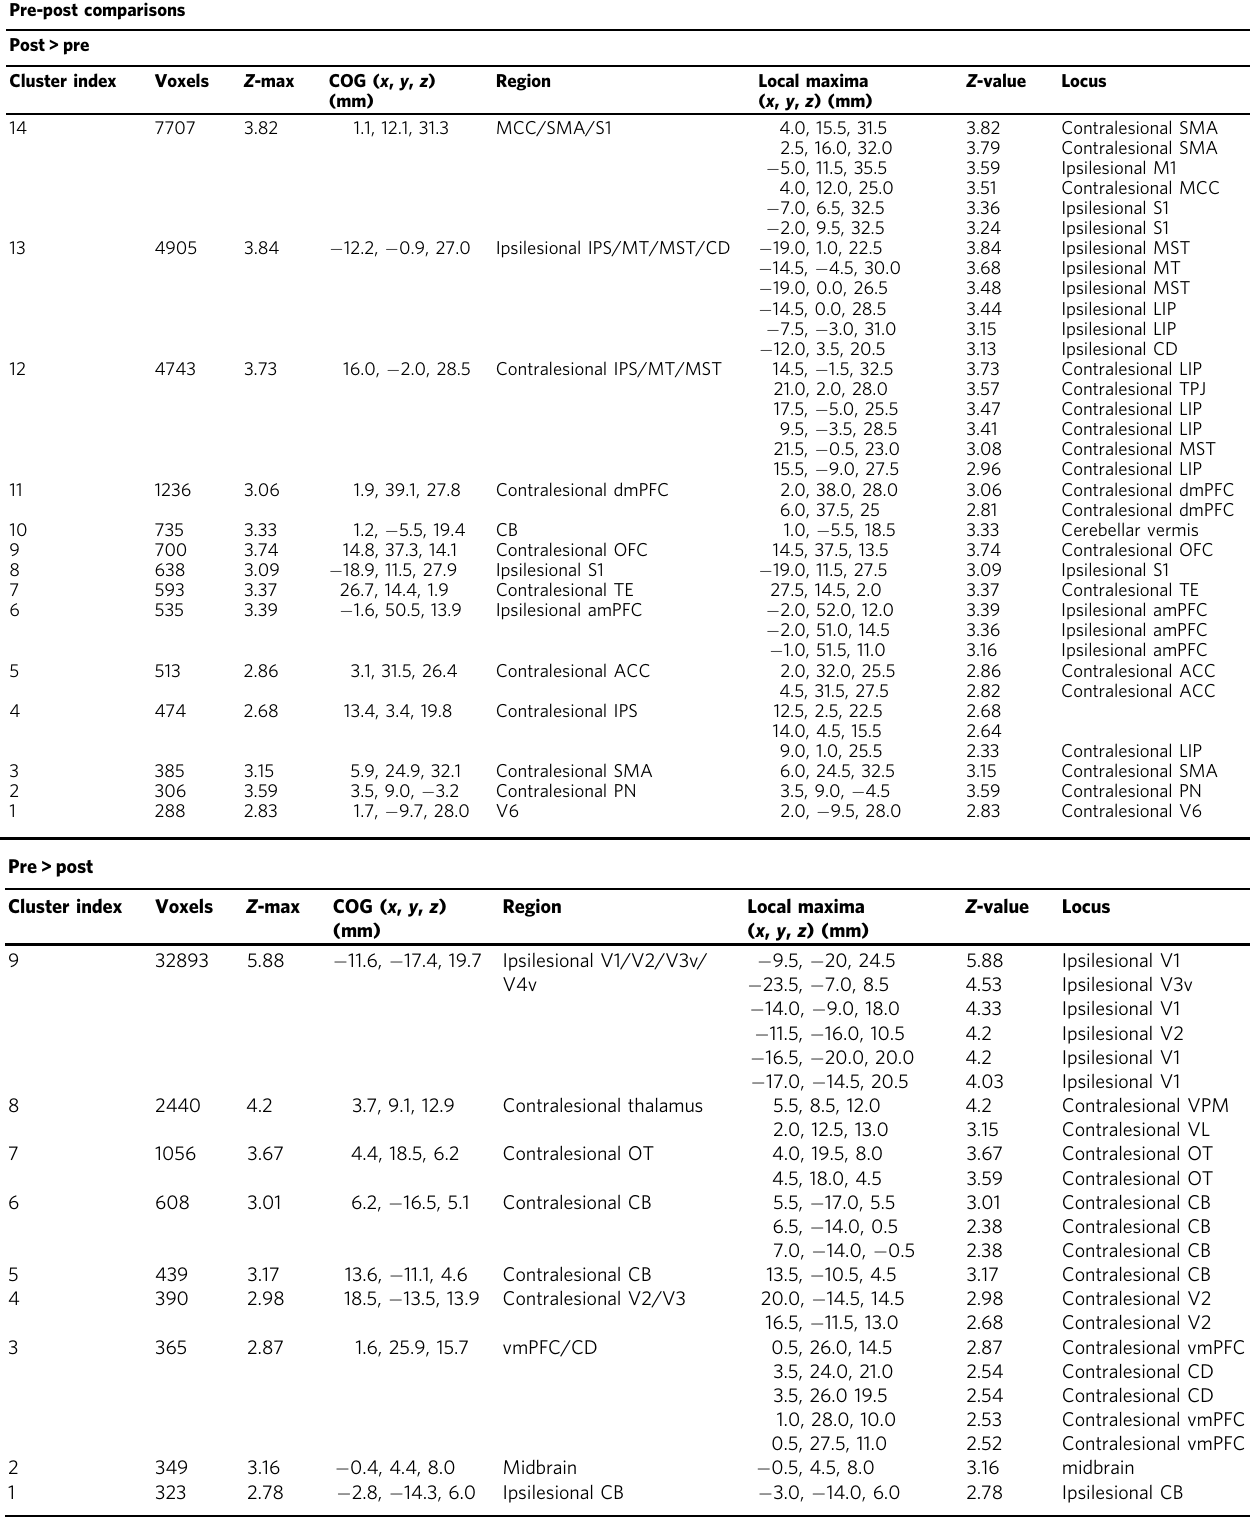
Table 3 Whole-brain statistical analysis of rCBF changes related to the interaction between task condition and